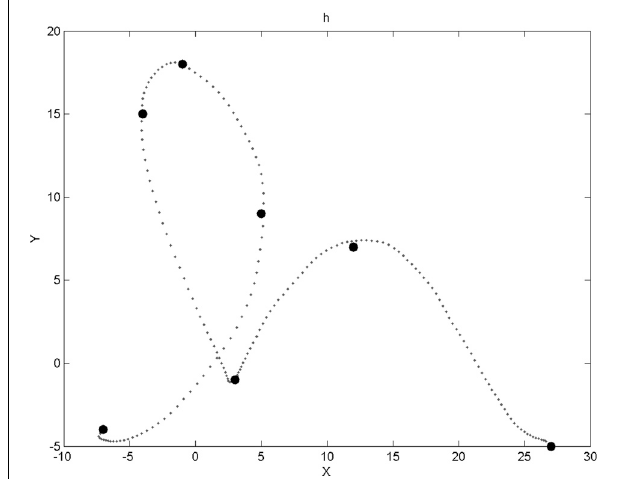
FIGURE 2 | Example of a trajectory for the letter “h” and the corresponding via-points positions. Via-points, where x and y velocities are zeroed, perceptually corresponds to extremes portions of the trajectories (i.e., bottom, top, left, and right borders of the local curvature). Notice that, after the first point of the trajectory, a via-point appears to be missing: it was filtered out by a geometric constraint that ensures that via-points are not too close to each other. Notice also that via-points sometimes appear out of the trajectory (and also in Figures 6 , 7 , 10 , 14 ): this is because we visualize here via-point positions in the low precision, discrete domains of the corresponding probabilistic variables (see the experimental Results